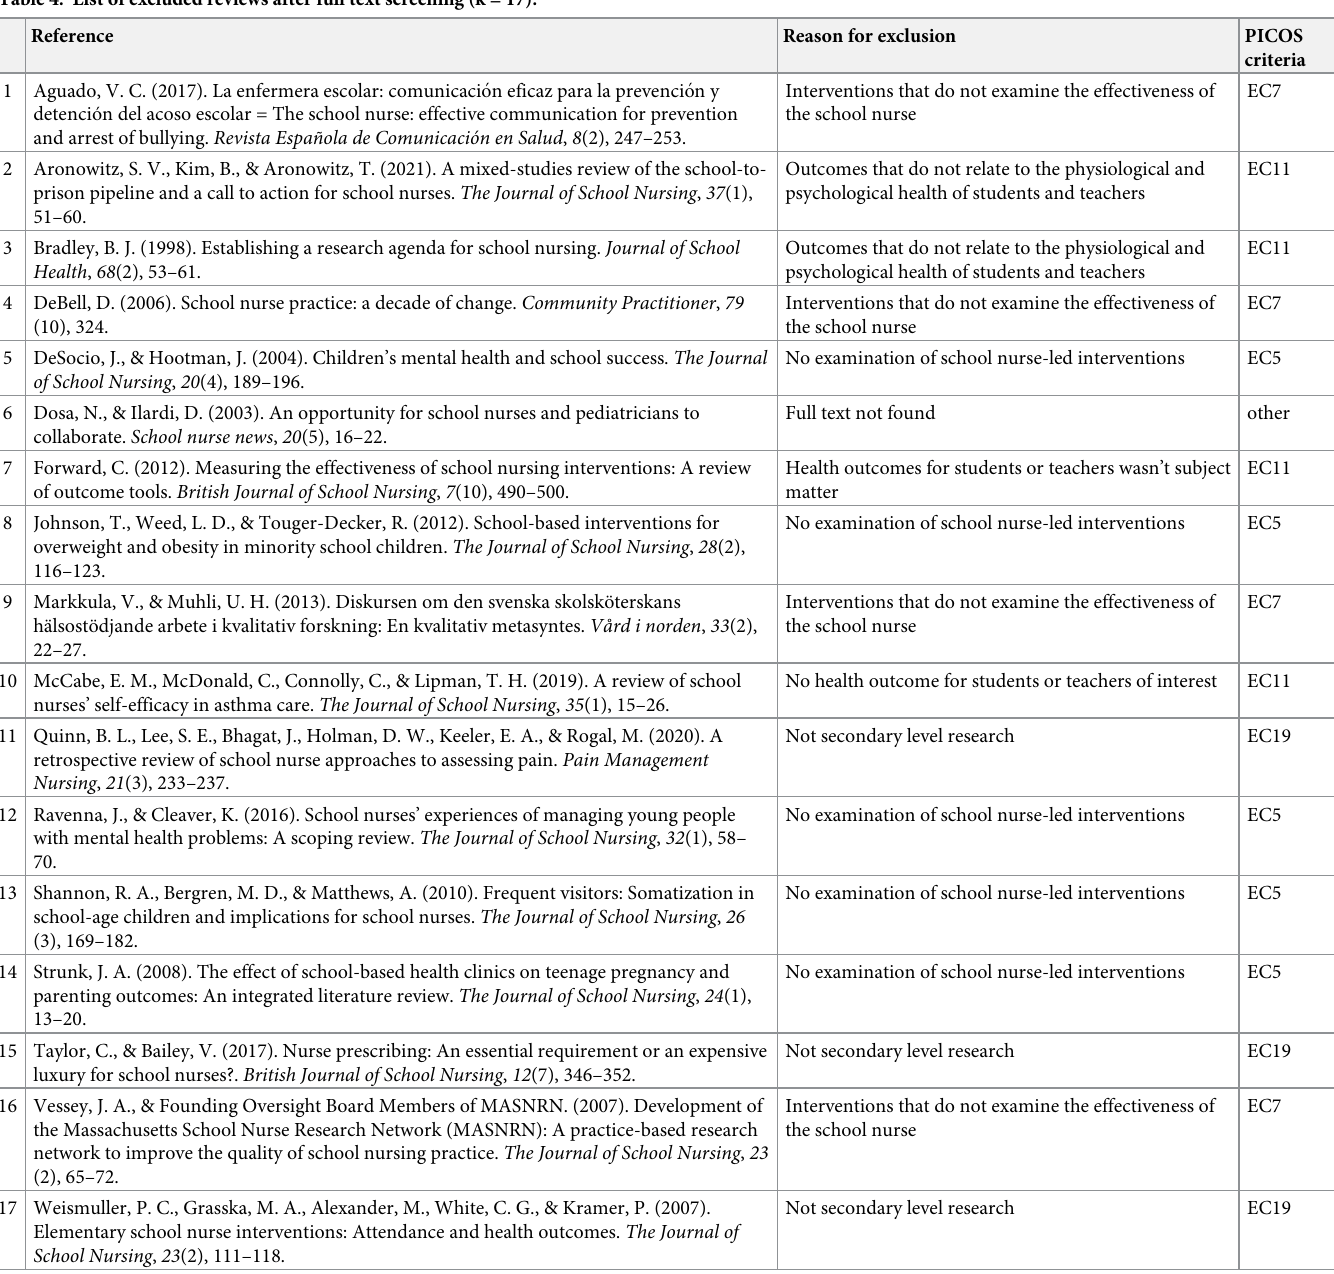
Table 4. List of excluded reviews after full text screening (k =